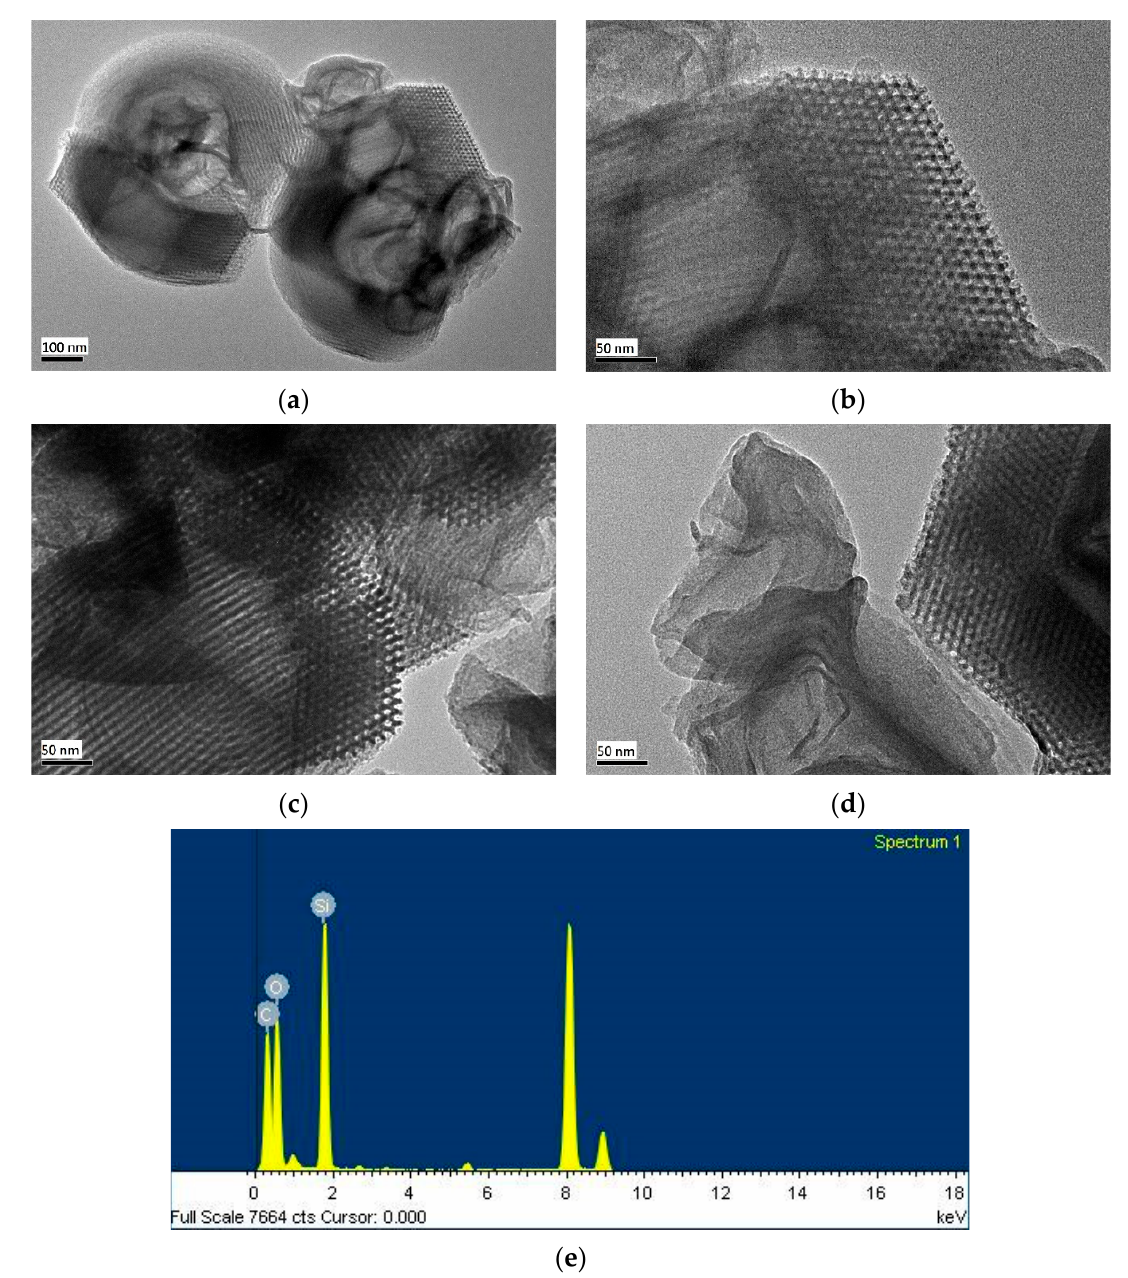
Figure 6. TEM pictures: ( a , b ) RH-SBA-15; ( c , d ) RH-GO/SBA-15; ( e ) EDS of RH-GO/SBA-15.